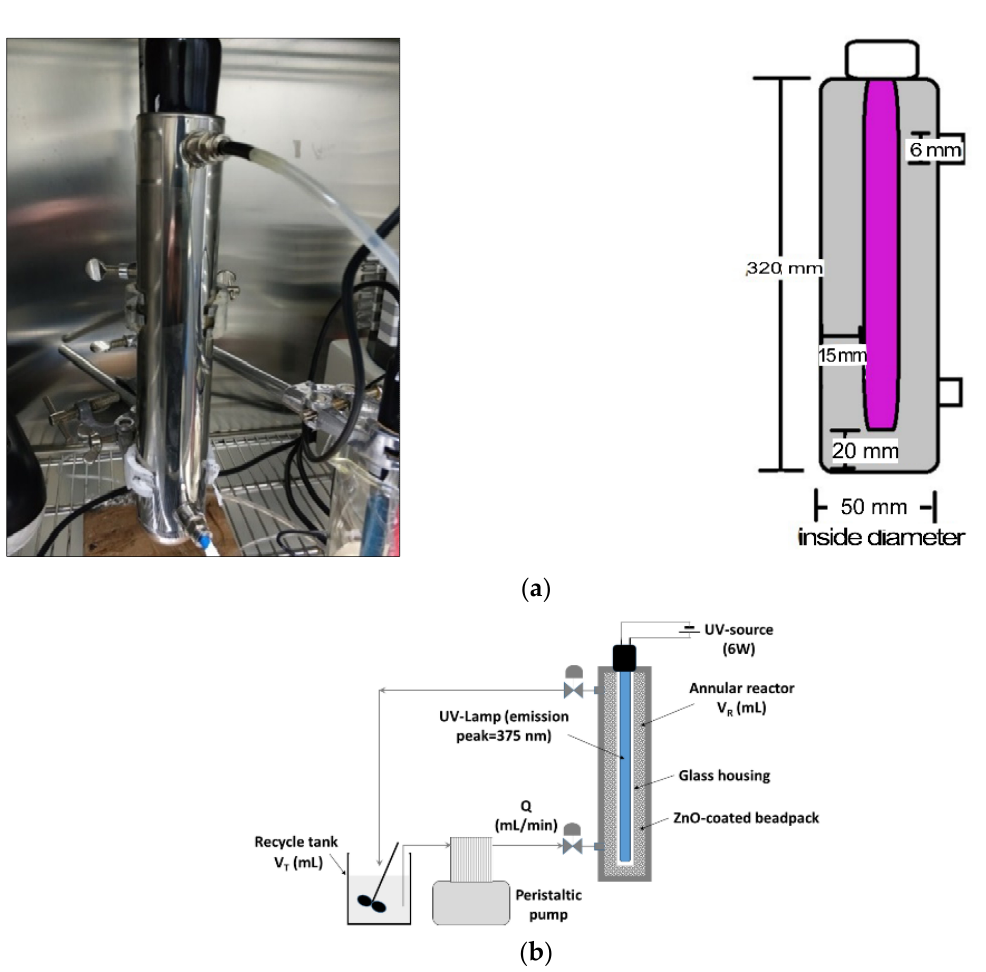
Figure 3. ( a ) Experimental setup of PMMA reactor and ( b ) schematic diagram with dimensions.